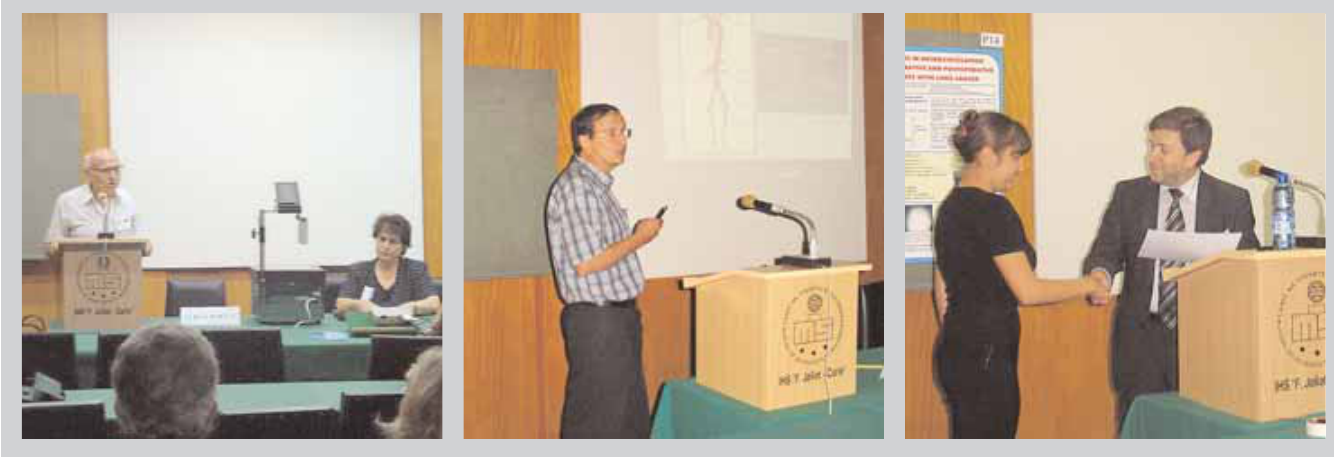
ology of Cells, Tisues and Systems on September 17,